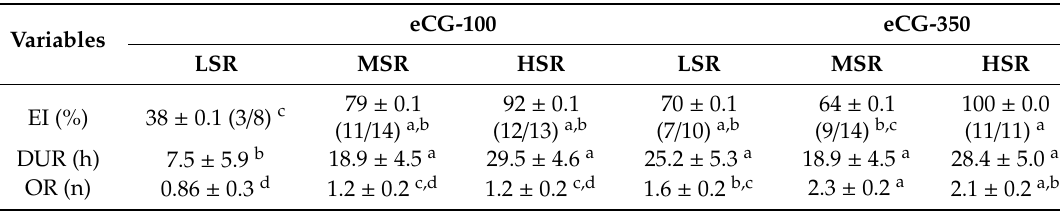
Table 2. Least-square means ± standard error for estrus induction (EI, %), duration of estrus (DUR, h), ovulation rate (OR, n), live weight (LW, kg), as a ff ected by the social rank (i.e., LSR, MSR and HSR) x eCG dose (i.e., 100 or 350 IU) interaction in crossbred (Alpine-Saanen-Nubian x Criollo; n = 70) dairy goats managed under intensive conditions in Northern Mexico (March, 25 ◦ N) 1